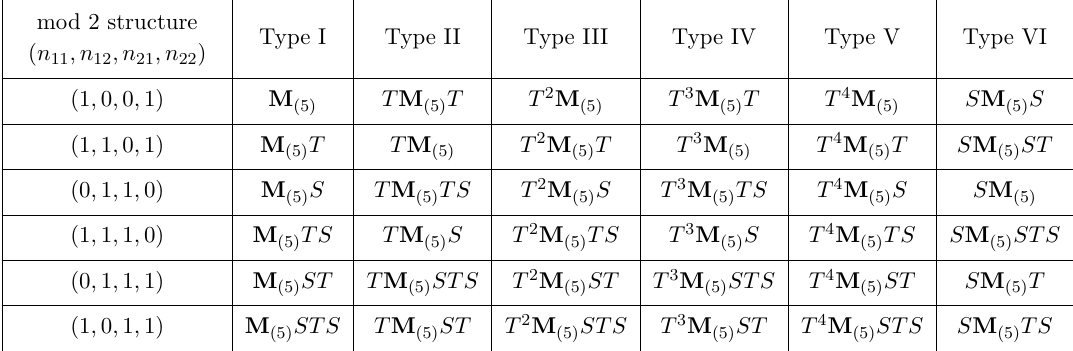
Table 7 . Classification by the mod 2 structure for D = 5